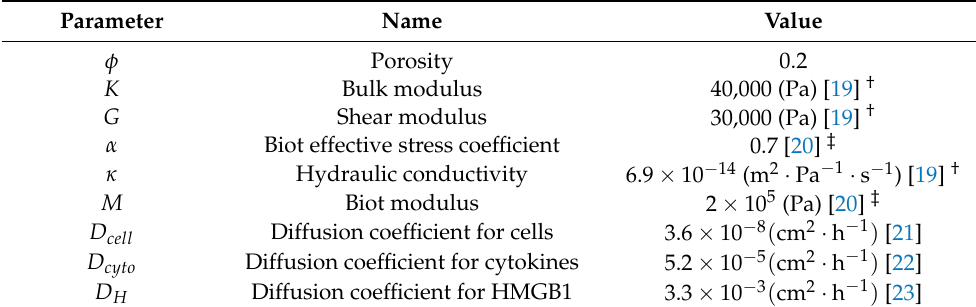
Table 2. Mechanical parameter